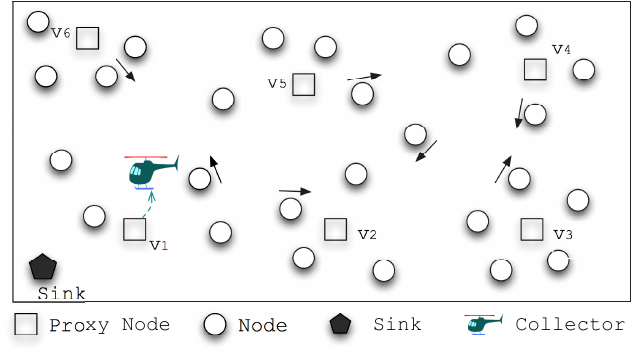
Figure 1. Illustration of data gathering using speedy mobile elements. Network meta-data are collected and extracted, based on which a set of proxy nodes are gathered. The data collector then follows the optimized schedule to pick up the sensed data from the proxy nodes through one hop transmissions, and then returns to the sink for data